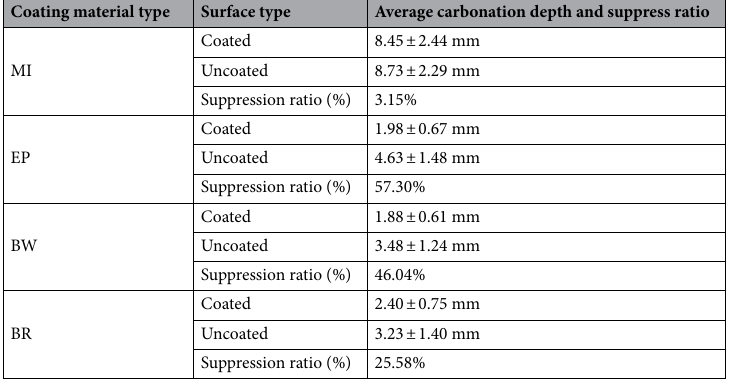
Table 6. Average carbonation depth and suppression